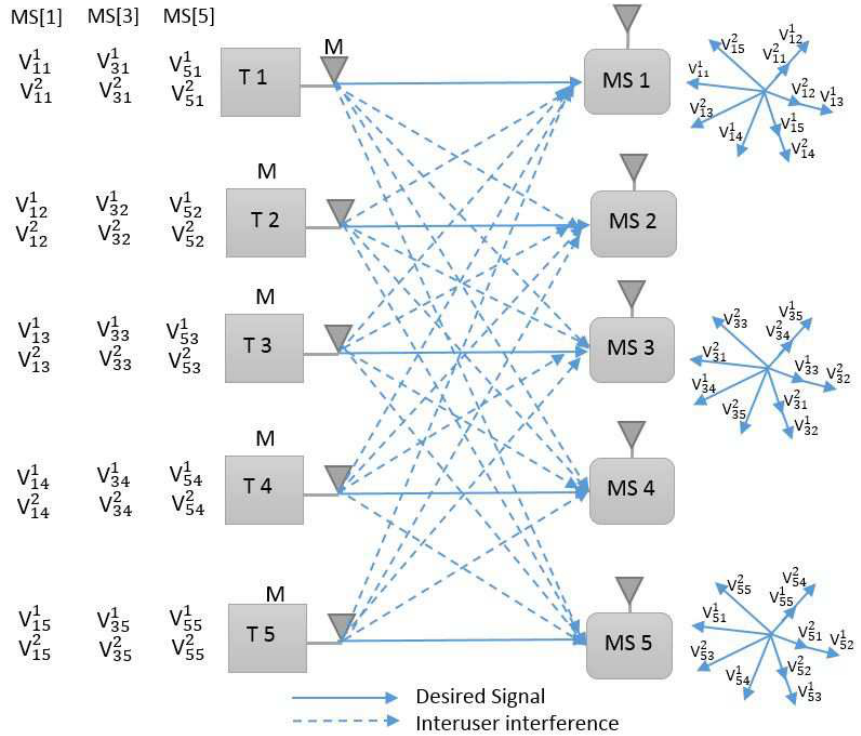
Figure 3. Description for the single-cell five-user multiple-input-multiple-output Gaussian interference channel with two preset modes, i.e., mobile station [1, 3, 5] interference